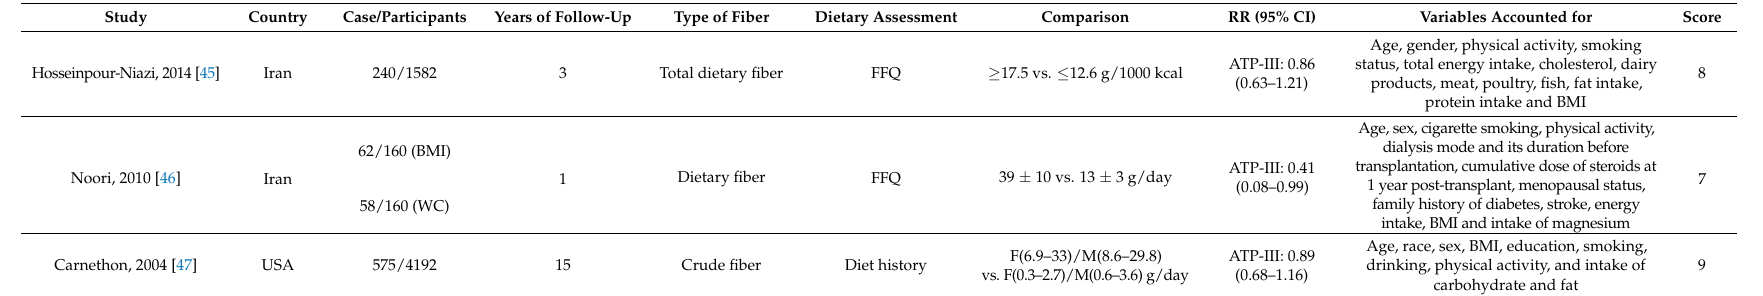
Table 2. Characteristics of published cohort studies on fiber consumption and